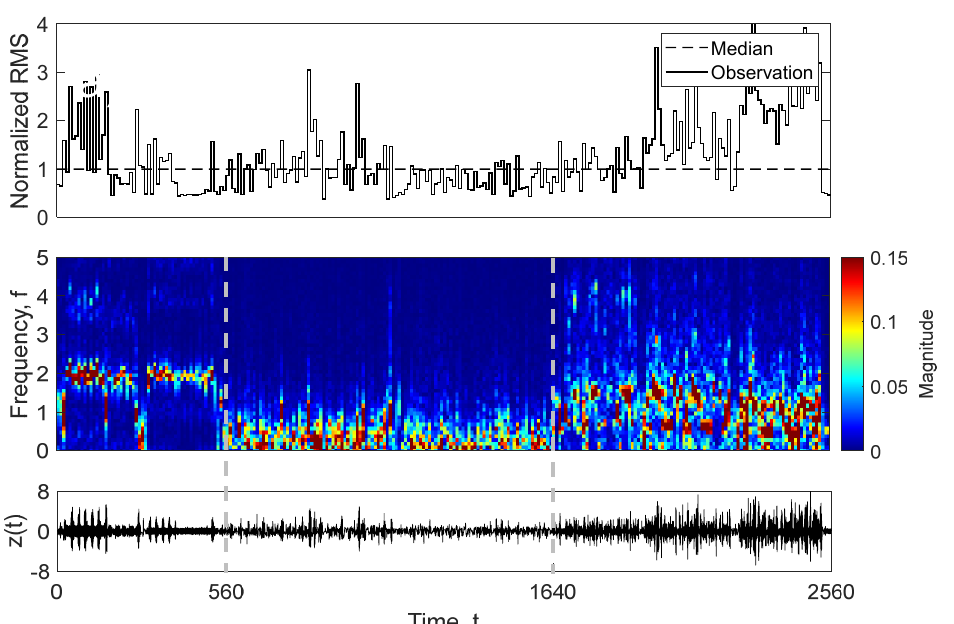
Figure 13. Short-time Fourier transform and run test applied to CH4 time history (inner rim), shown at the bottom of the figure. In both methods, the window time length was 10 s.